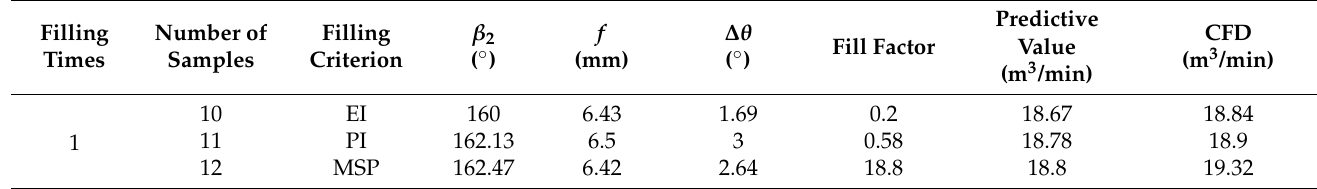
Table 5. Filling process of RKM in the initial stage.